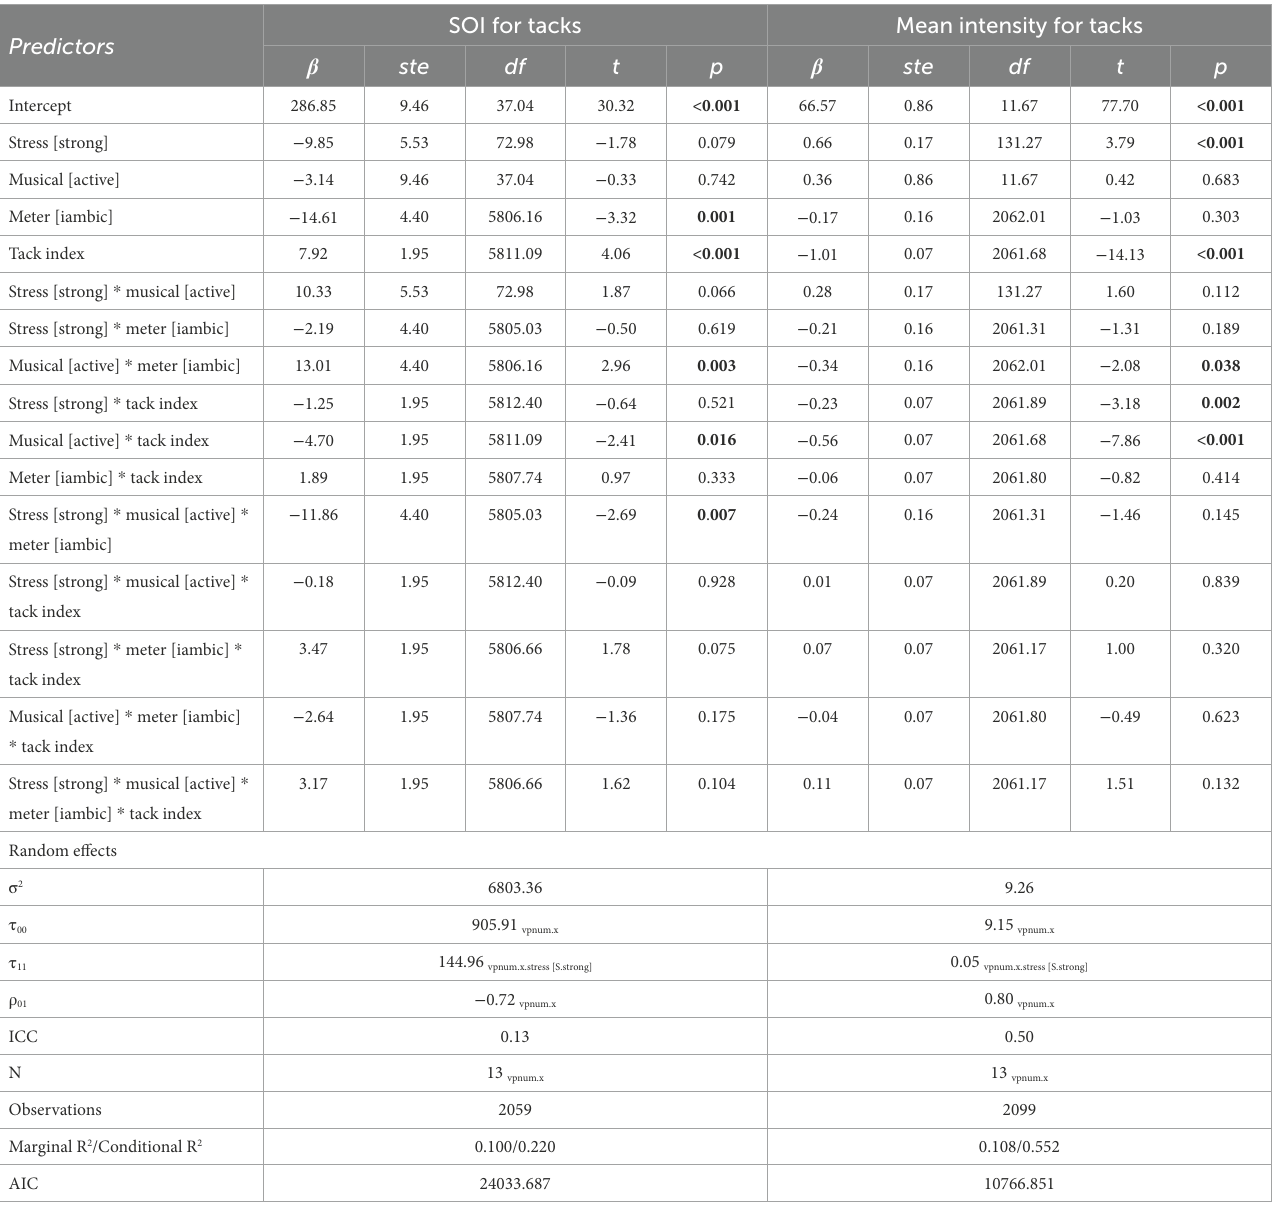
TABLE 2 Syllable onset intervals and mean intensity for variable tack syllables.